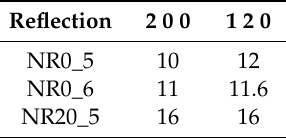
Table 2. Width of the orientation distribution (deviation from stretching direction), approximated by a Gaussian distribution, in degrees.